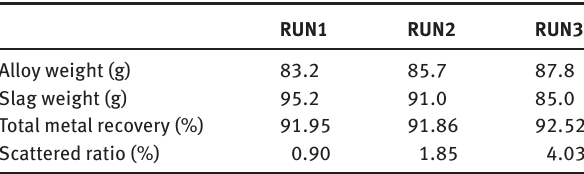
Table 2: Weight of products, total metal recoveries and scattered ratios of SHS reactions by the addition of 20 mass% Al 2 O 3 into